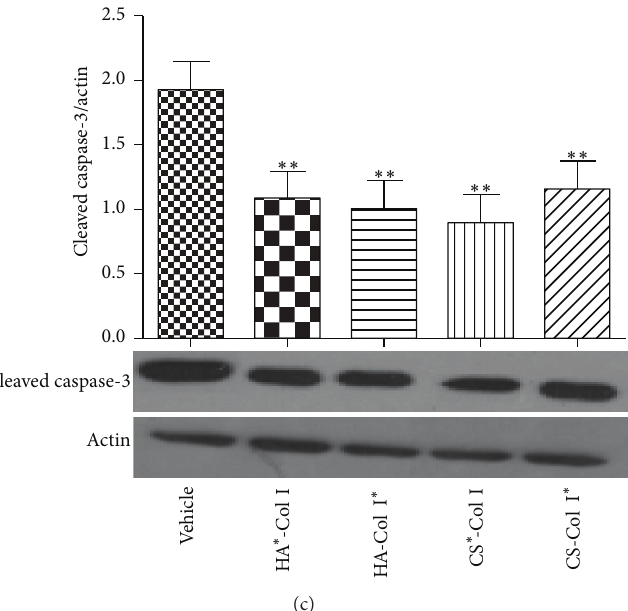
Figure 1: Effects of multilayer composite biomaterial membranes on EPC apoptosis. (a) EPC apoptosis determined by Hoechst 33258 staining (red arrows). (b) EPC apoptosis determined by Annexin V-PE/7-AAD staining and flow cytometric analysis. (c) Cleaved caspase-3 expression detected by western blot. ∗∗ 𝑝 < 0.01 versus vehicle, 𝑛 = 3 /group.